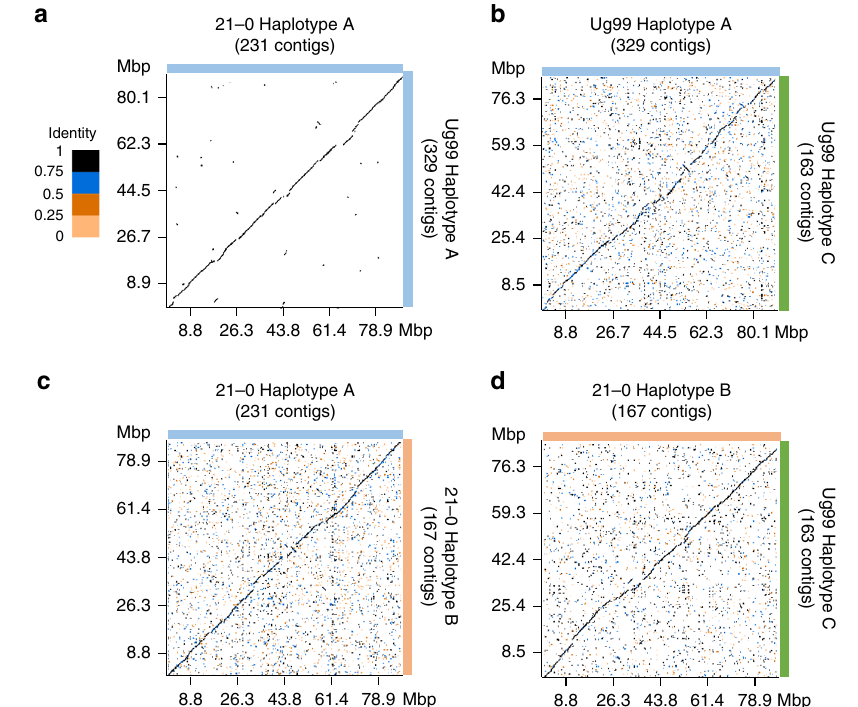
Fig. 4 Pgt 21-0 and Ug99 share one nearly identical haploid genome. a – d Dot plots illustrating sequence alignment of complete haplotypes. X - and y -axes show cumulative size of the haplotype assemblies depicted by coloured bars to the right and top of the graphs. Colour key indicates sequence identity ratios for all dot plots